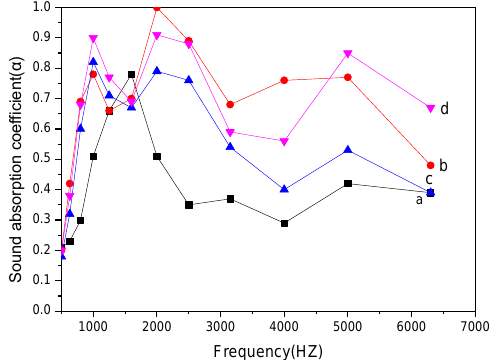
Figure 8. Effect of composite sound absorption properties. ( a ) composite of 8 wt % PVA and needle-punched nonwoven; ( b ) composite of 8 wt % PVA/3 wt % PEO (90/10) and needle-punched nonwoven; ( c ) composite of 8 wt % PVA/3 wt % PEO (80/20) and needle-punched nonwoven; ( d ) composite of 8 wt % PVA/3 wt %PEO (70/30) and needle-punched nonwoven.